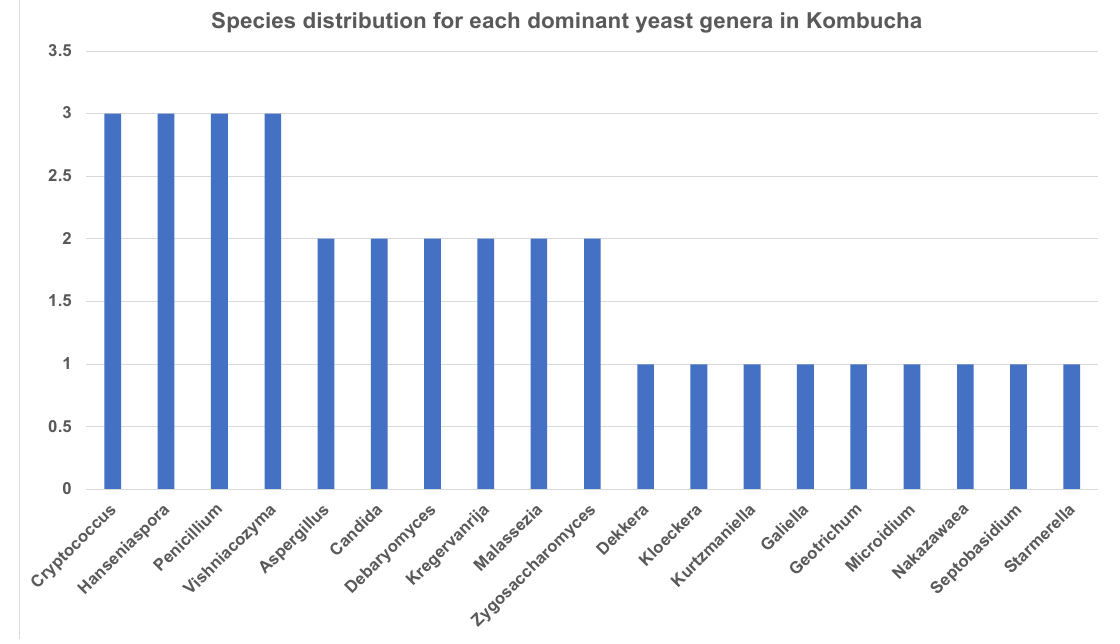
Figure 4. Most dominant yeast genera across the kombucha samples. More reads match to the genus Starmerella followed by Galiella and Hanseniaspora . The error bars are standard error (SE) calculated across the triplicate values of samples.